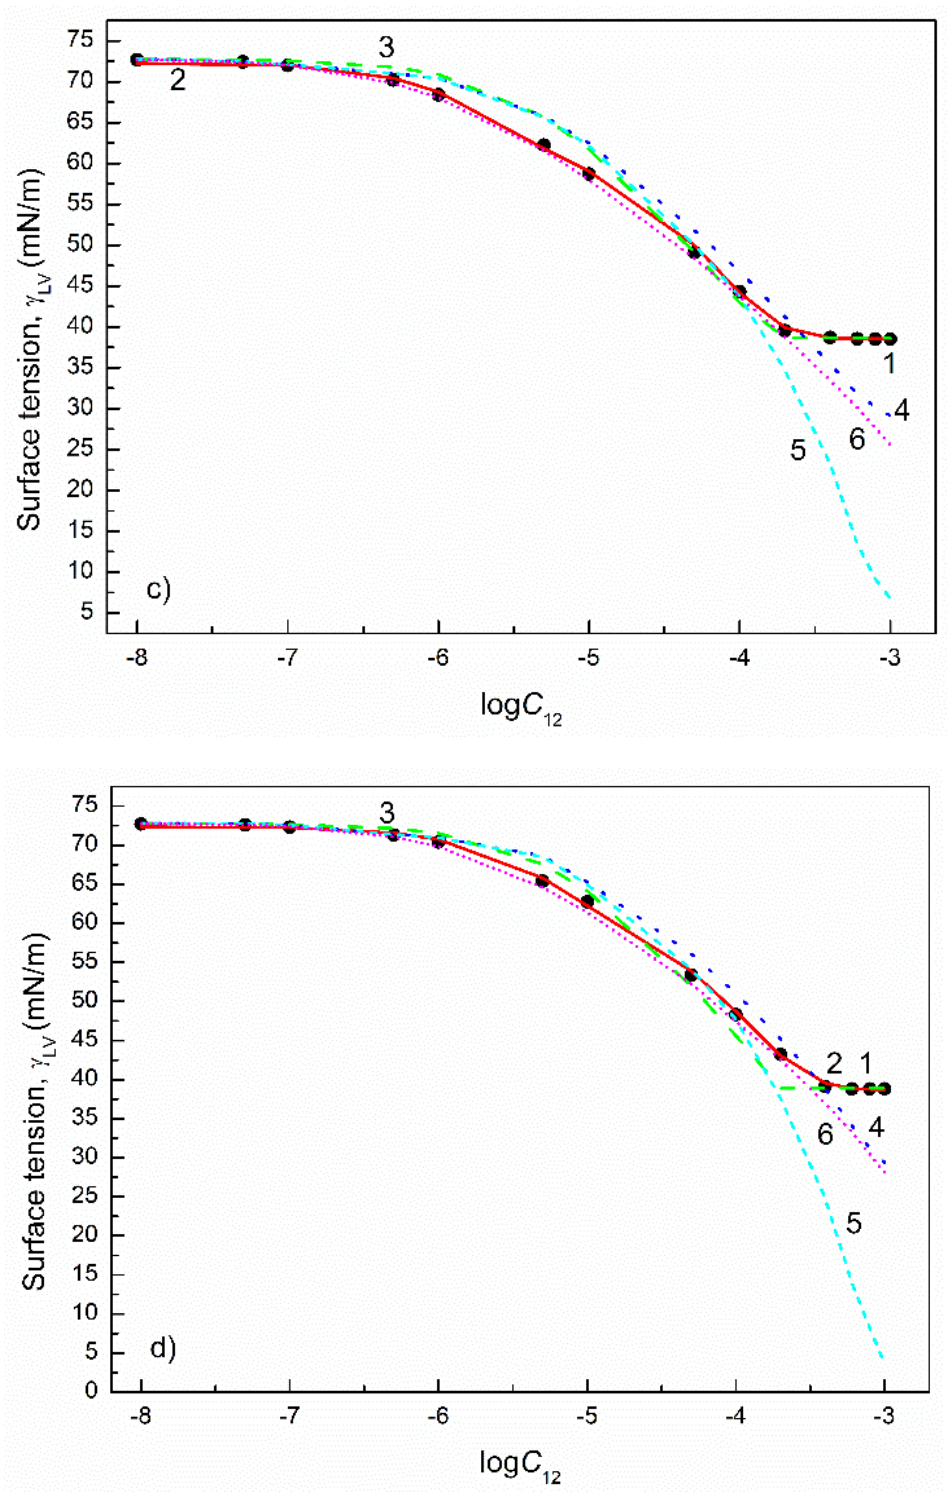
Figure 9. A plot of the surface tension ( γ LV ) of the aqueous solutions of CTAB+TX100 mixtures at the CTAB mole fraction in the bulk phase ( α ) equal to 0.2 ( a ), 0.4 ( b ), 0.6 ( c ) and 0.8 ( d ) vs. the logarithm of the mixture concentration ( logC 12 ). Points 1 correspond to the measured values [22], curves 2–6 correspond to the values calculated from the exponential function of the second order (Equation (2)), Szyszkowski equation (Equation (3)), Fainerman and Miller equation (Equation (11)), independent adsorption (Equation (10)) and Joos equation (Equation (13)), respectively.